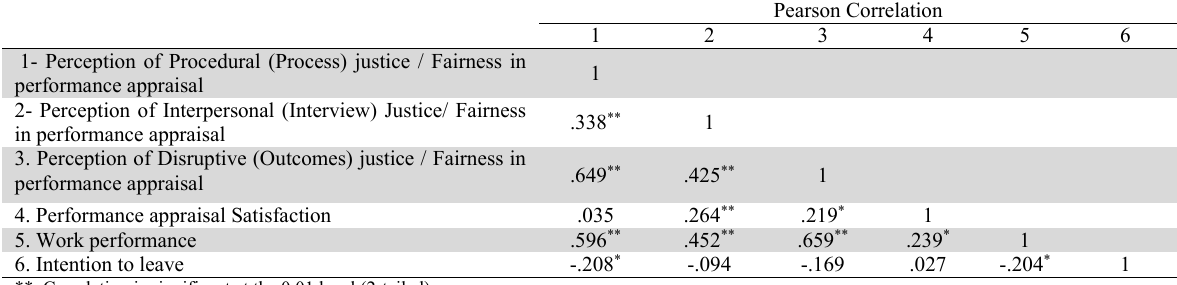
Pearson Correlation